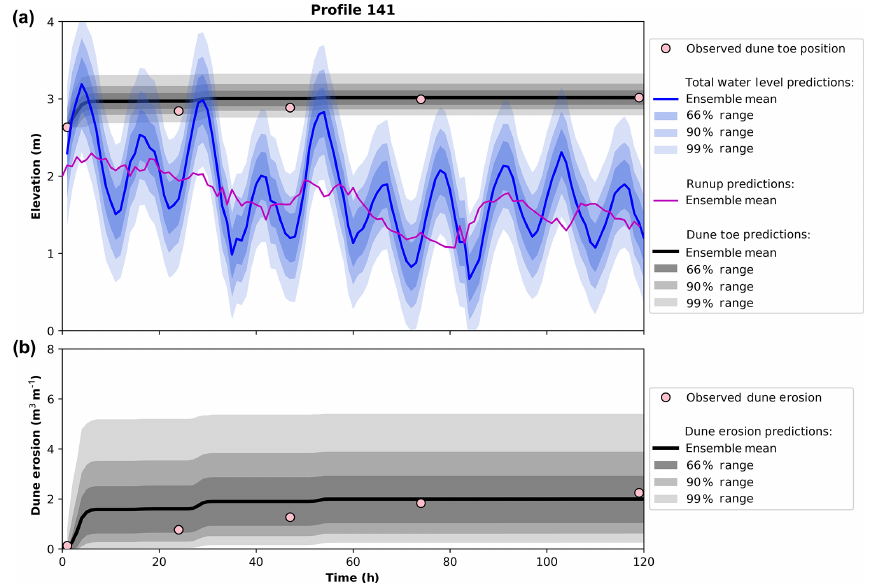
Figure 7. Example of LEH04 used with the Gaussian process R 2 predictor to form an ensemble of dune erosion predictions. A total of 10000 runup models are drawn from the Gaussian process and used to force the LEH04 model. (a) Total water level (measured water level + R 2 ; blue) and dune toe elevation (grey) for the 120h storm event. The bold coloured line is the mean of the ensemble, and shaded areas represent the regions captured by 66%, 90%, and 99% of the ensemble predictions. An example of just the R 2 prediction (no measured water level) from the Gaussian process is shown in the magenta line. Pink dots denote the observed dune toe elevation throughout the storm event. (b) The corresponding ensemble of dune erosion predictions.